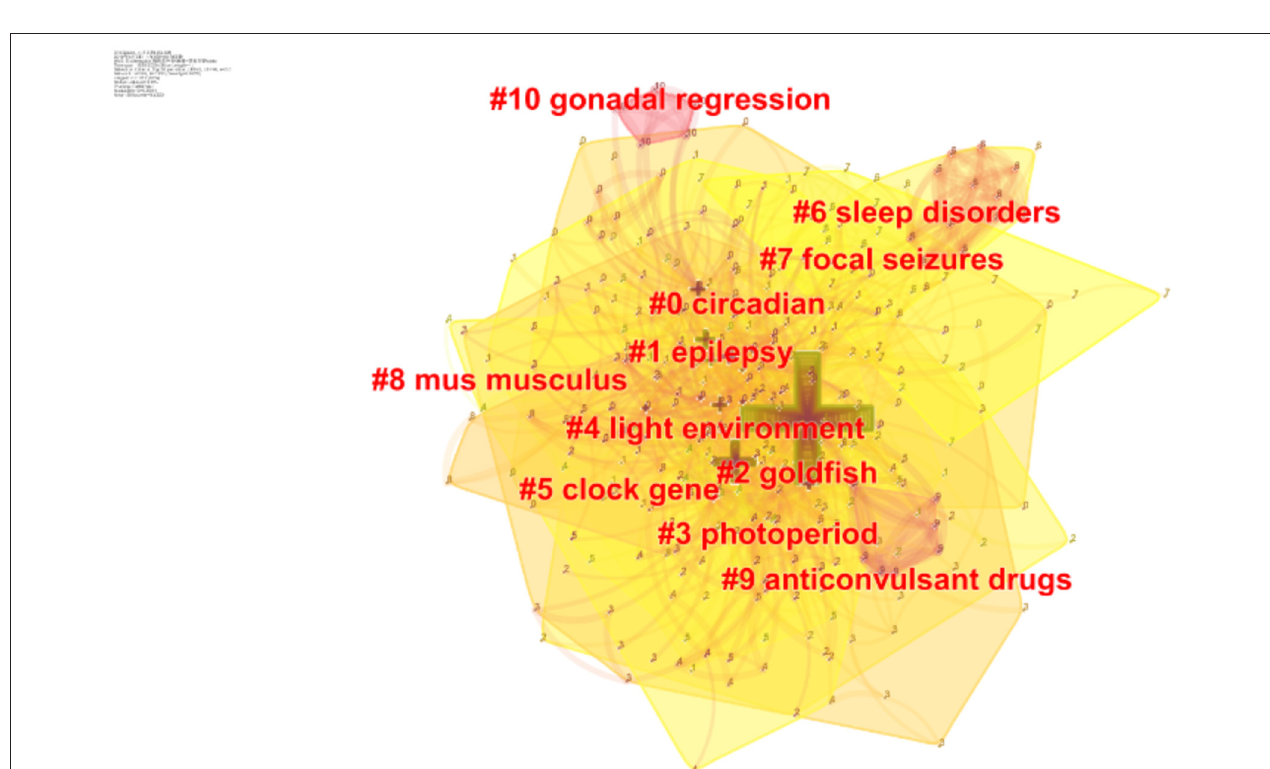
FIGURE 6 | Keywords cluster analysis co-occurrence